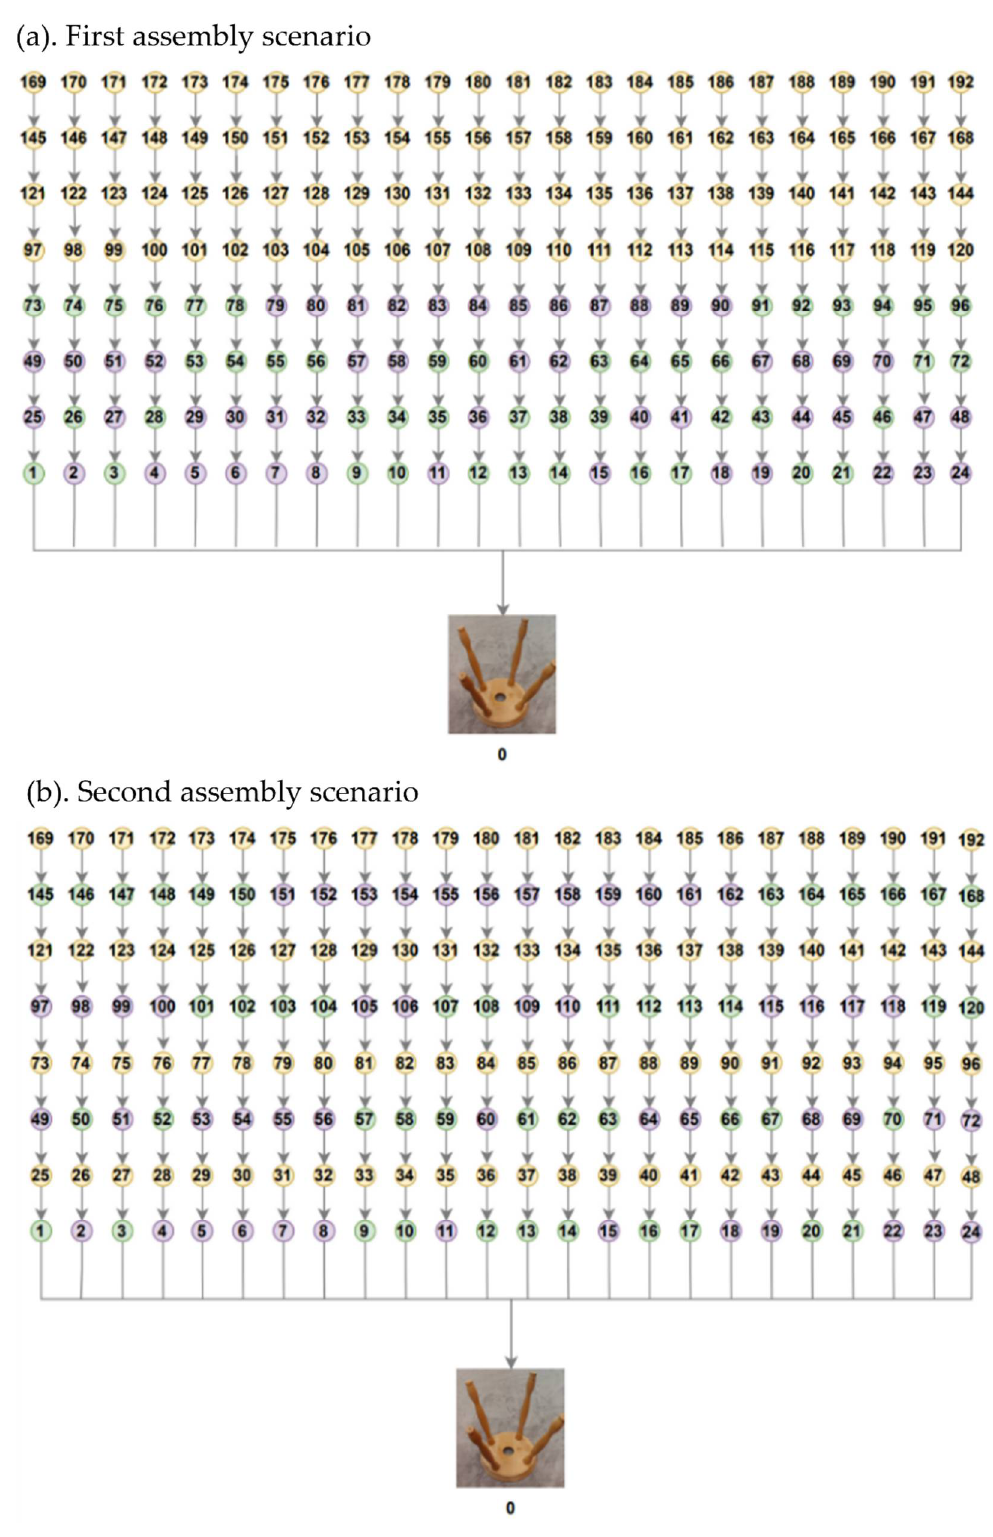
Figure 16. First ( a ) and Second ( b ) Assembly Scenarios.